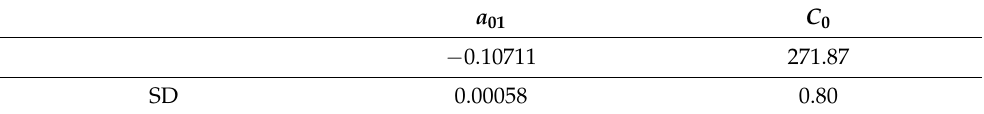
Table 1. Calculated coefficients of Equation (5) and their standard